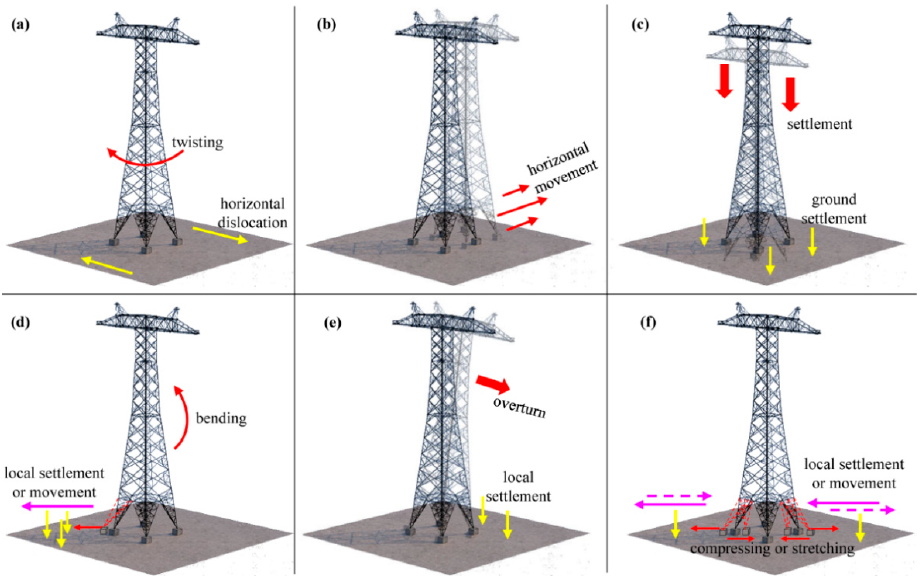
Figure 4. Possible failure modes of a high-voltage pylon: ( a ) twisting deformation, ( b ) horizontal movement, ( c ) vertical settlement, ( d ) bending, ( e ) overturn and ( f ) base-stretching/compressing.